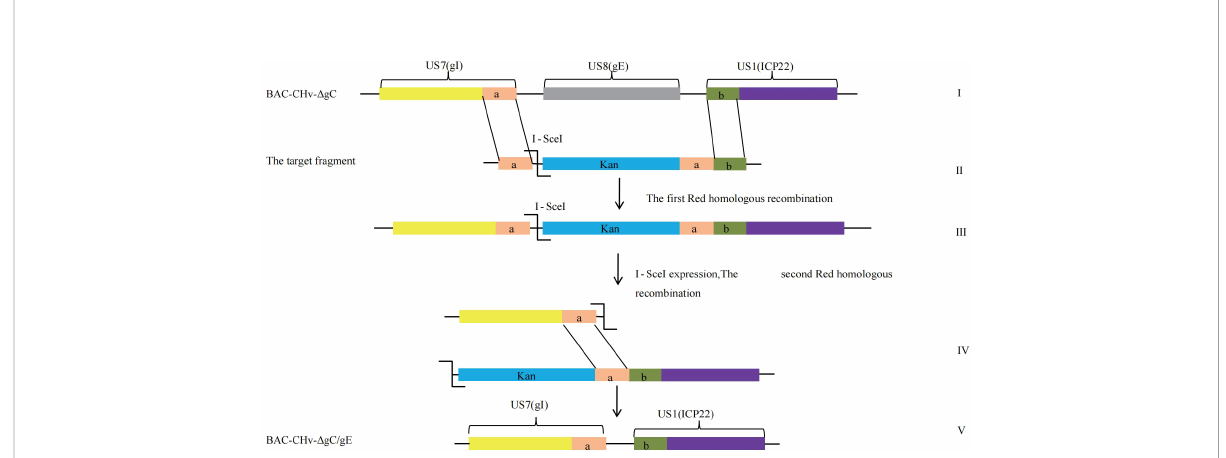
FIGURE 1 Homologous recombination diagram. Schematic diagram of constructing CHv- D gC/gE using Red recombination system. "a" and "b" represent the terminal sequences of the Us7 gene and the Us1 gene,